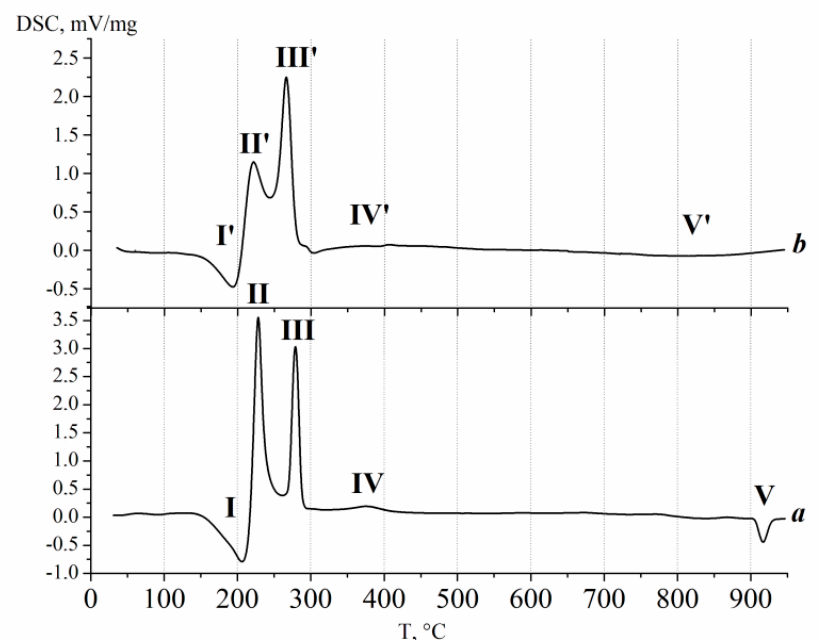
Figure 4. DSC curves of a mixture of FeC 2 O 4 ·2H 2 O and CoC 2 O 4 ·2H 2 O without preliminary treat- ment ( a ) and after mechanical activation for 45 min ( b ).